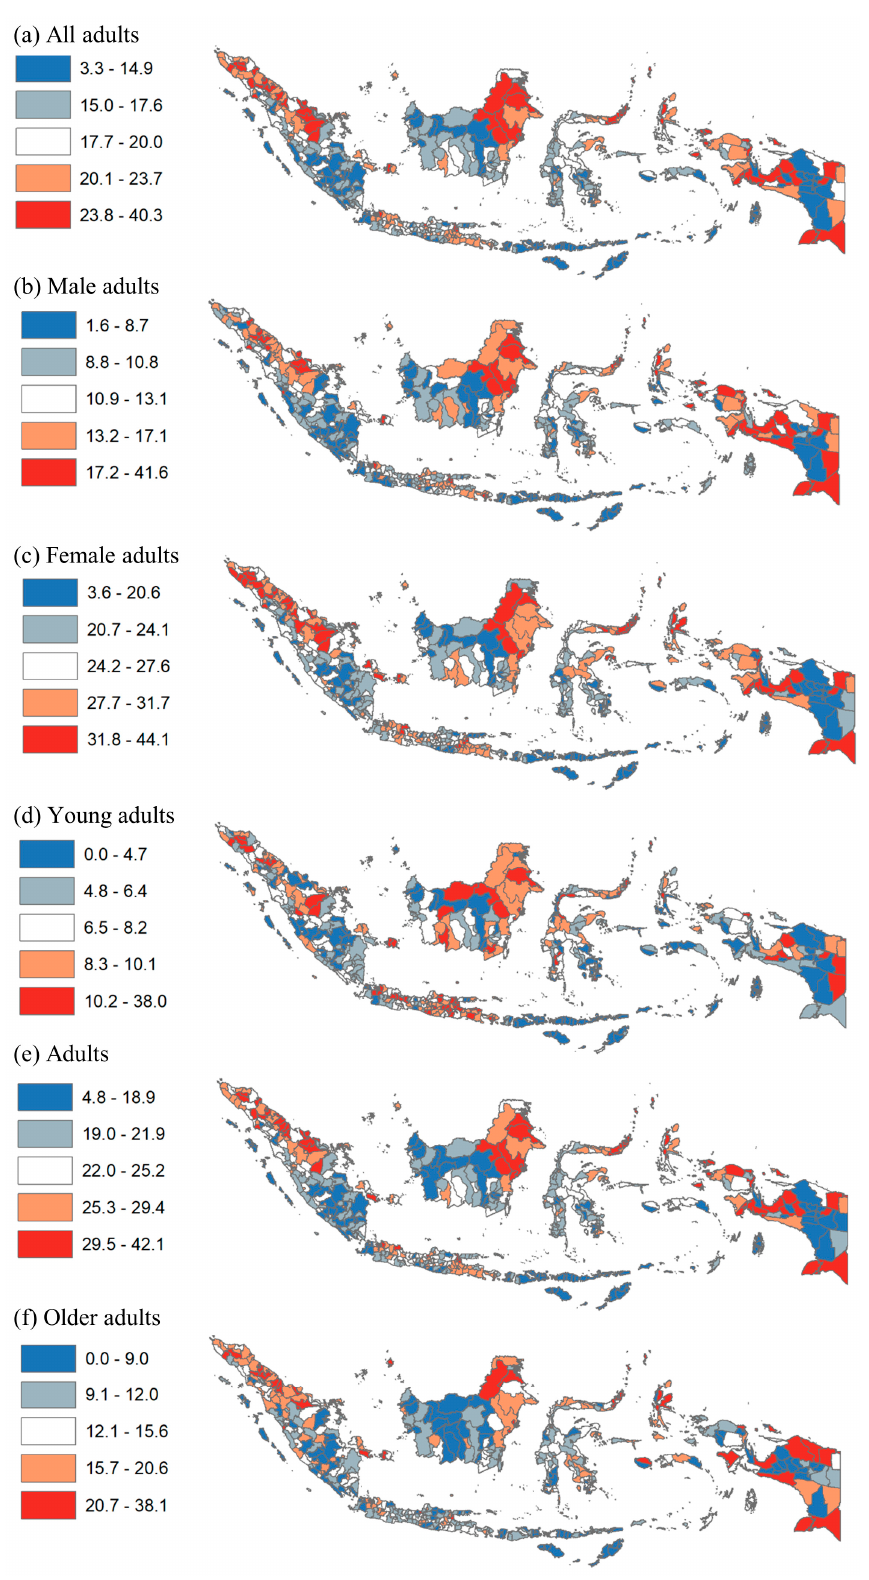
Figure 3. Disparity of obesity among adults by district in Indonesia, 2018. Note: Numbers show prevalence of obesity among all adults, males, females, young adults, adults, and older adults.